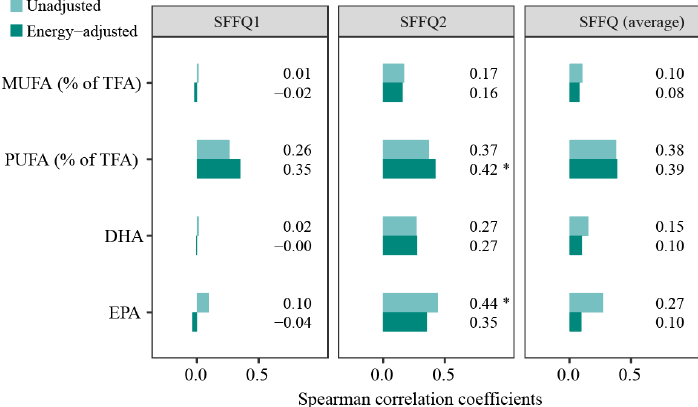
Figure 3. Spearman correlation coefficients (r s ) of dietary intakes estimated by the SFFQ in different periods against the intake biomarkers. * p < 0.05. SFFQ1: data showed the habitual intakes for the last year of the biomarker measurements. SFFQ2: data showed the habitual intakes for the same year of the biomarker measurements. SFFQ (average): data showed the average levels between SFFQ1 and SFFQ2. Energy-adjusted: total energy intake was adjusted. MUFA (% of TFA): the percentage of monounsaturated fatty acids to total fatty acids. PUFA (% of TFA): the percentage of polyunsaturated fatty acids to total fatty acids. DHA: docosahexaenoic acid, EPA: eicosapentaenoic acid.